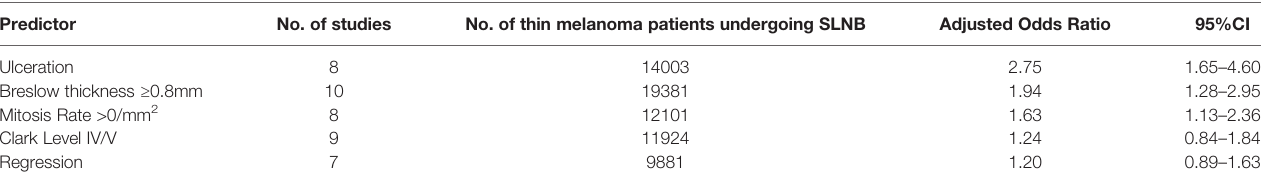
TABLE 3 | Pooled adjusted odds ratio of high-risk pathologic features.